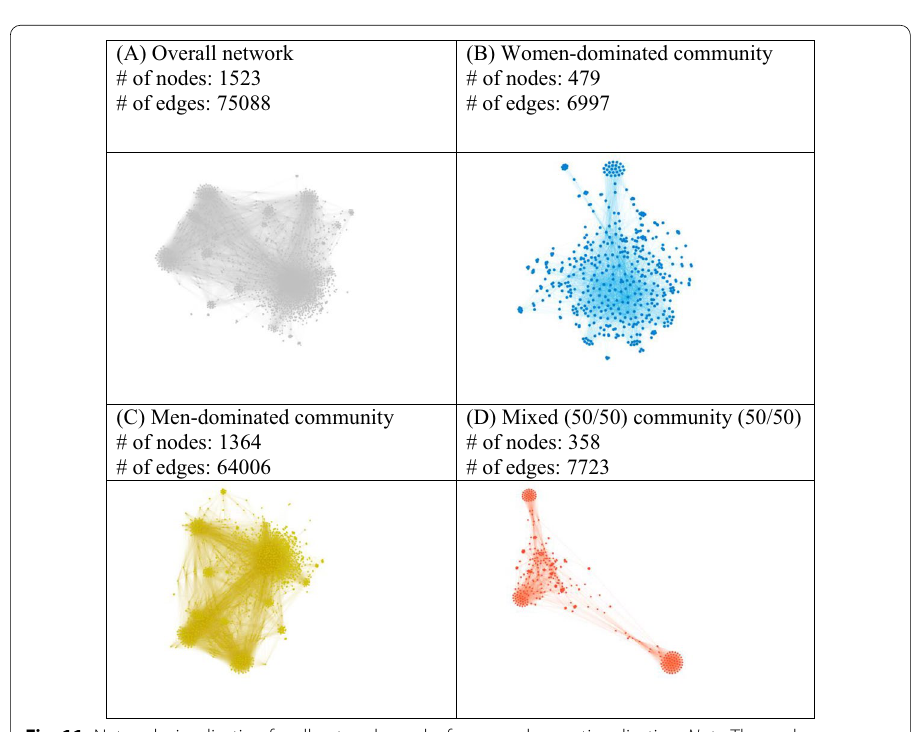
Fig. 11 Network visualization for all network graphs for second operationalization. Note : The nodes are festivals connected, if they screen the same film. Overall, 1523 festivals are connected through the screening of 1323 films. This induces 75,088 (weighted) edges between festivals. In the grey overall network ( A ), festivals can be connected by sharing one or more films made by women-dominated, men-dominated or mixed (50/50) core creative teams. The colored networks show festivals that are connected through sharing one or more films made by women-dominated core creative teams ( B ), made by men-dominated core creative teams ( C ), and made by mixed (50/50) core creative teams ( D ). The same festival may appear in all gendered community graphs. Layout based on Force Atlas Algorithm in Gephi